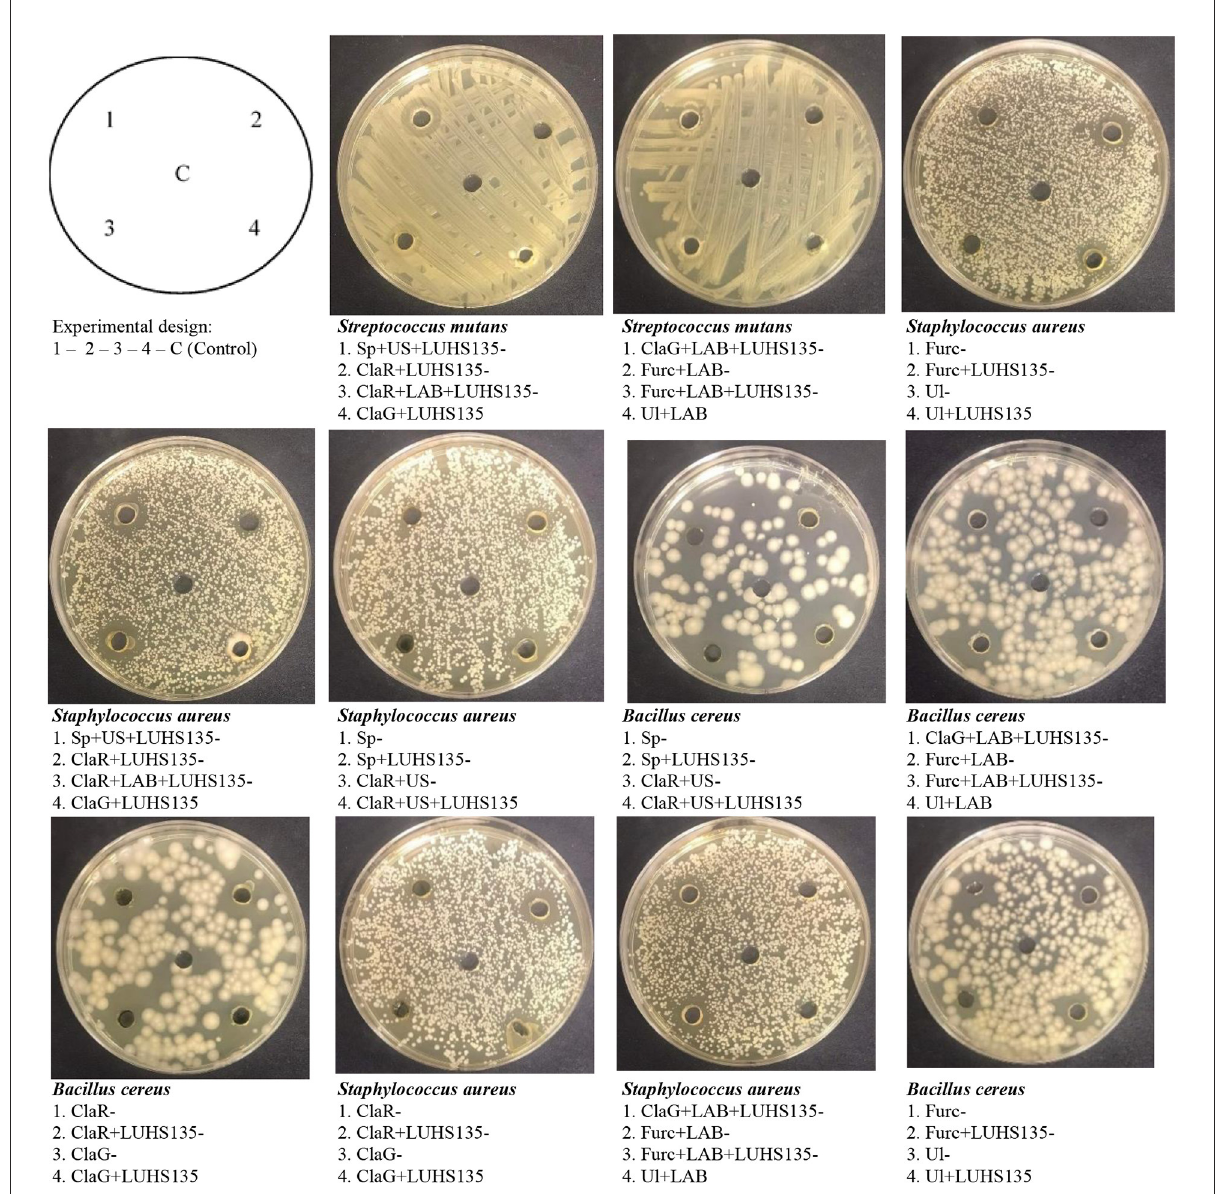
FIGURE3 Images of the inhibition zones of the algae extracts and algae extracts × LUHS135 combinations evaluated using the agar well diffusion method [ClaR, Cladophora rupestris; ClaG, Cladophora glomerata; Ul, Ulva intestinalis; Furc, Furcellaria lumbricalis; Sp, Spirulina (Arthrospira platensis)]; US, algae biomass pre-treated with ultrasound; LAB, algae biomas fermented with LUHS135 strain before extraction; LUHS135, extract composition with LUHS135 strain; C,control (physiological